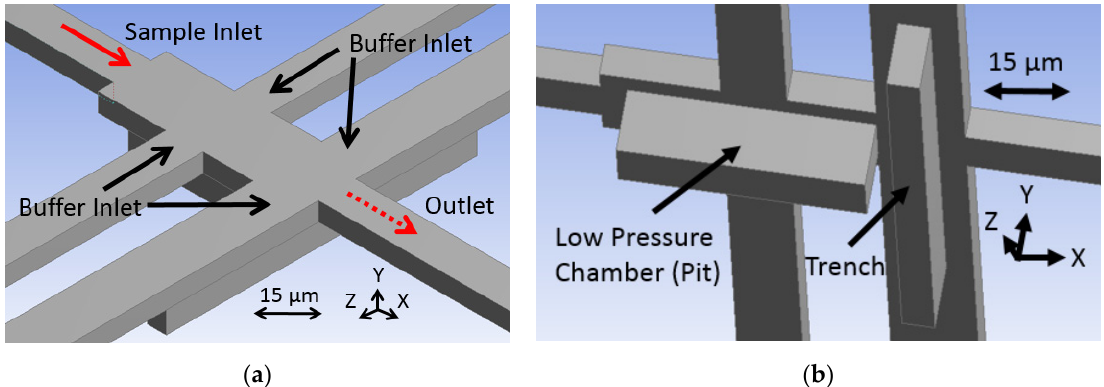
Figure 2. Schematics show ( a ) an above oblique view of the focusing junction describing the operation principle in which sample flow is shown in red, buffer flow in black, and outlet flow in dashed red, and ( b ) a beneath oblique view showing the etched features.